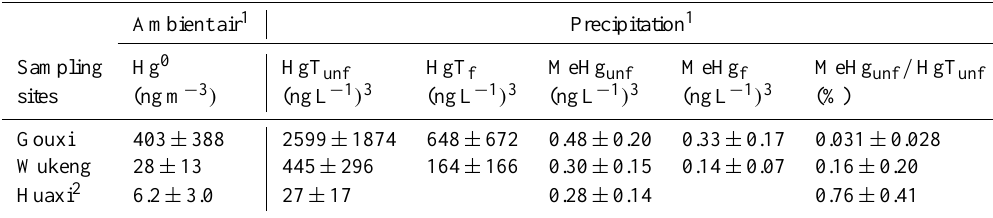
Table 2. Hg in ambient air and precipitation at artisanal Hg mining site (Gouxi), abandoned Hg mining site (Wukeng), and regional back- ground of Huaxi (mean ± SD).